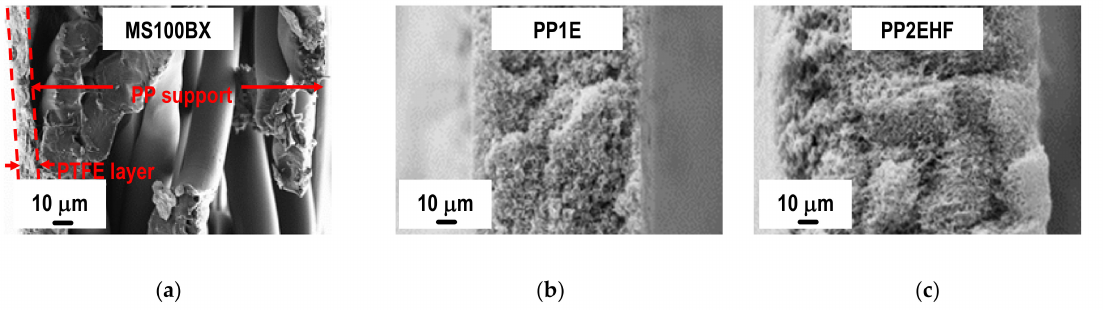
Figure 4. FESEM micrographs of the cross-section of the MS100BX ( a ), PP1E ( b ), and PP2EHF ( c ) membranes.